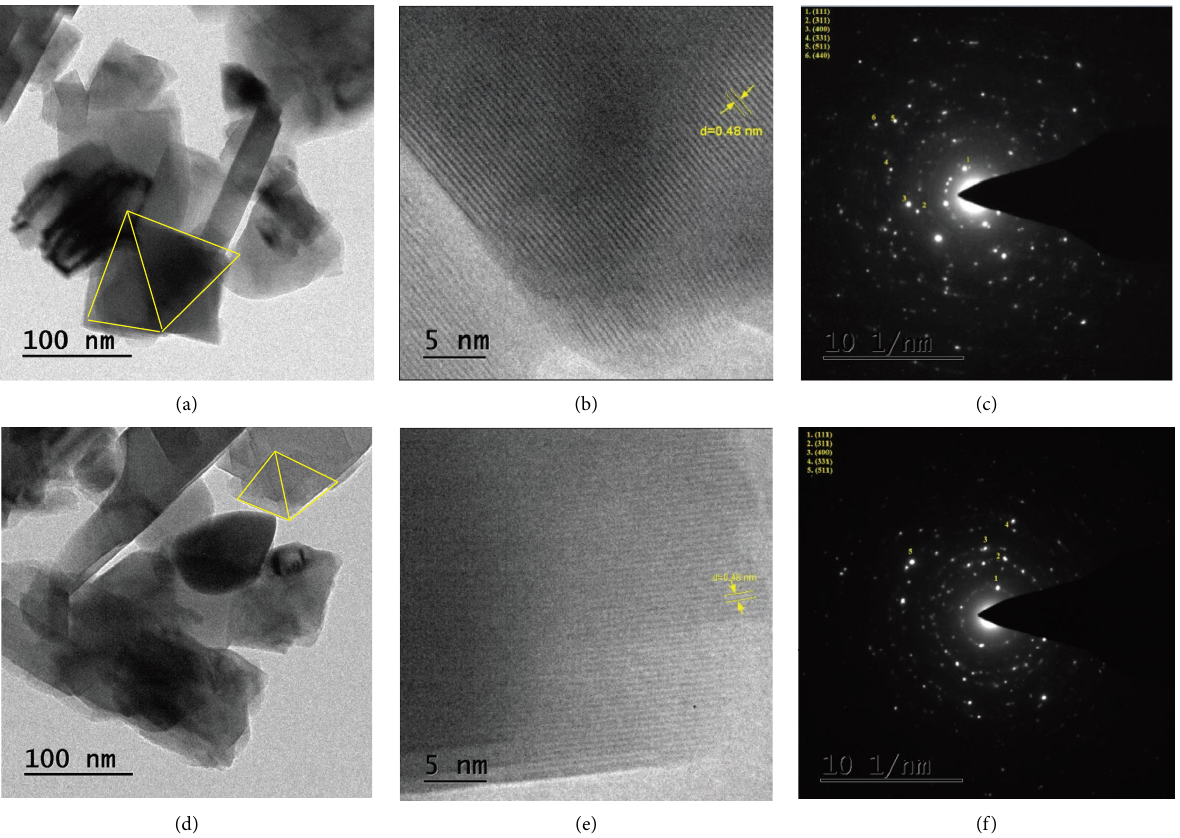
Figure 6: TEM and HRTEM images of (a, b) Li 4 Mn 5 O 12 and (d, e) Li 4 Mn 4.75 Sm 0.25 O 12 and its corresponding SAED pattern (c, f). Table 2: Comparison of d-spacing from the XRD and SAED pattern. hkl plane PowderX